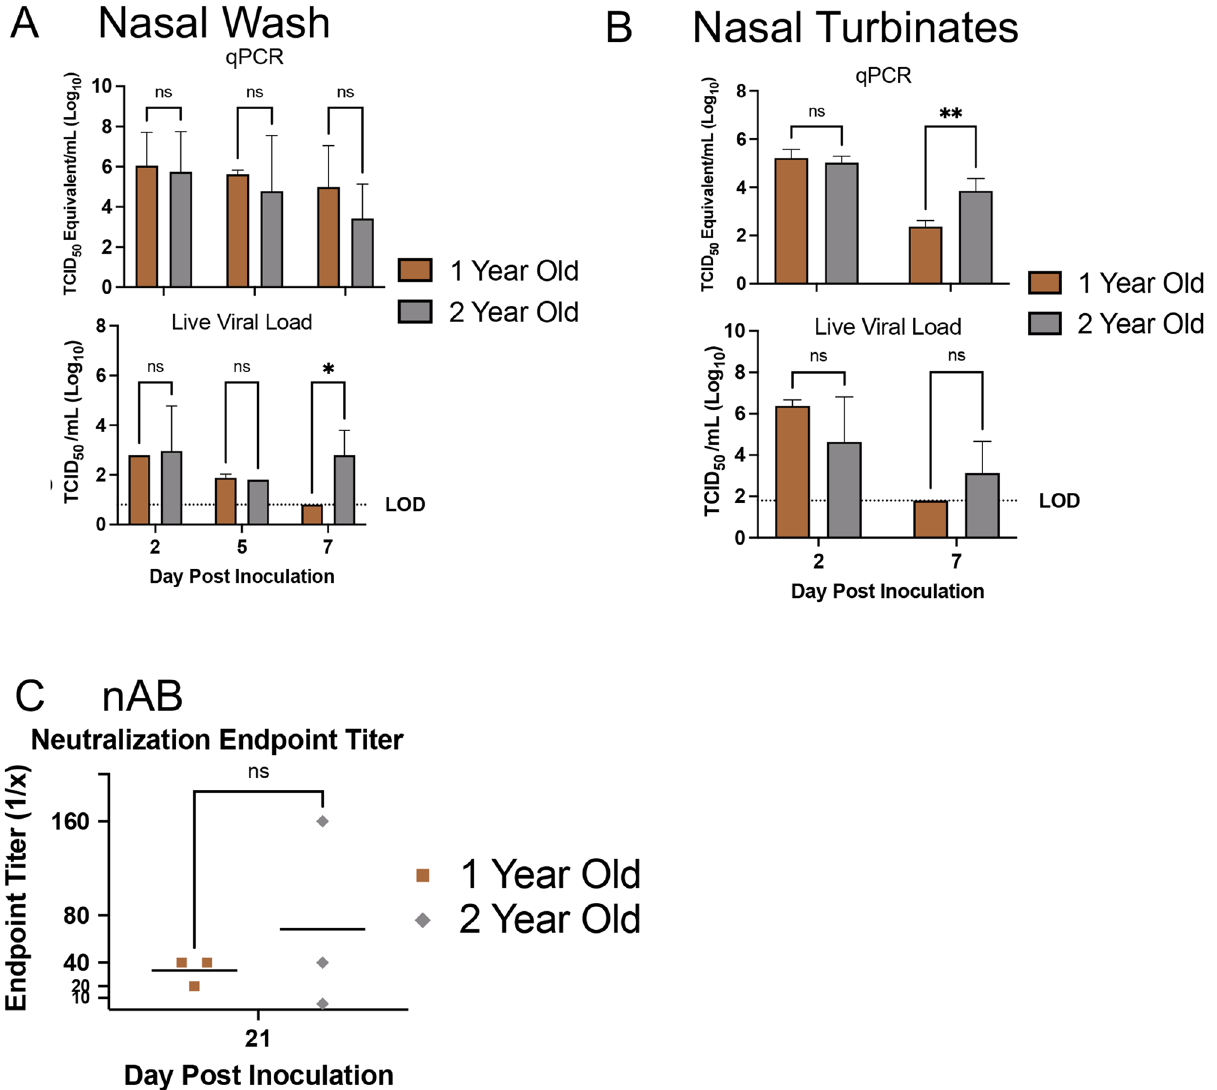
Figure 4. Prolonged SARS-CoV-2 viral presence occurs after infection in upper respiratory tract of 2-year-old ferrets compared to 1-year-old ferrets. ( A ) Nasal washes were collected from 1-year-old and 2-year-old ferrets to quantify SARS-Co-V-2 by qPCR and live viral load assay. Infectious titer of TCID 50 /mL was calculated using the Reed and Muench method. ( B ) vRNA and live virus was also quantified in the nasal turbinates. ( C ) Virus neutralization titers were determined by standard neutralization assays using plasma collected from both groups on day 21. LOD = limit of detection. Error bars represent SD. *A p-value of less than 0.05 as determined by ANOVA or Student’s t-test as appropriate. N is 3 for all